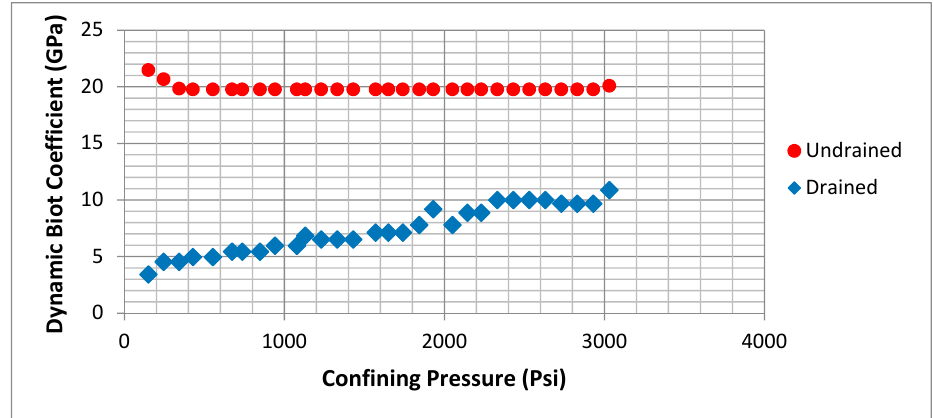
Figure 15. Biot coefficient vs. confining pressure for H4.